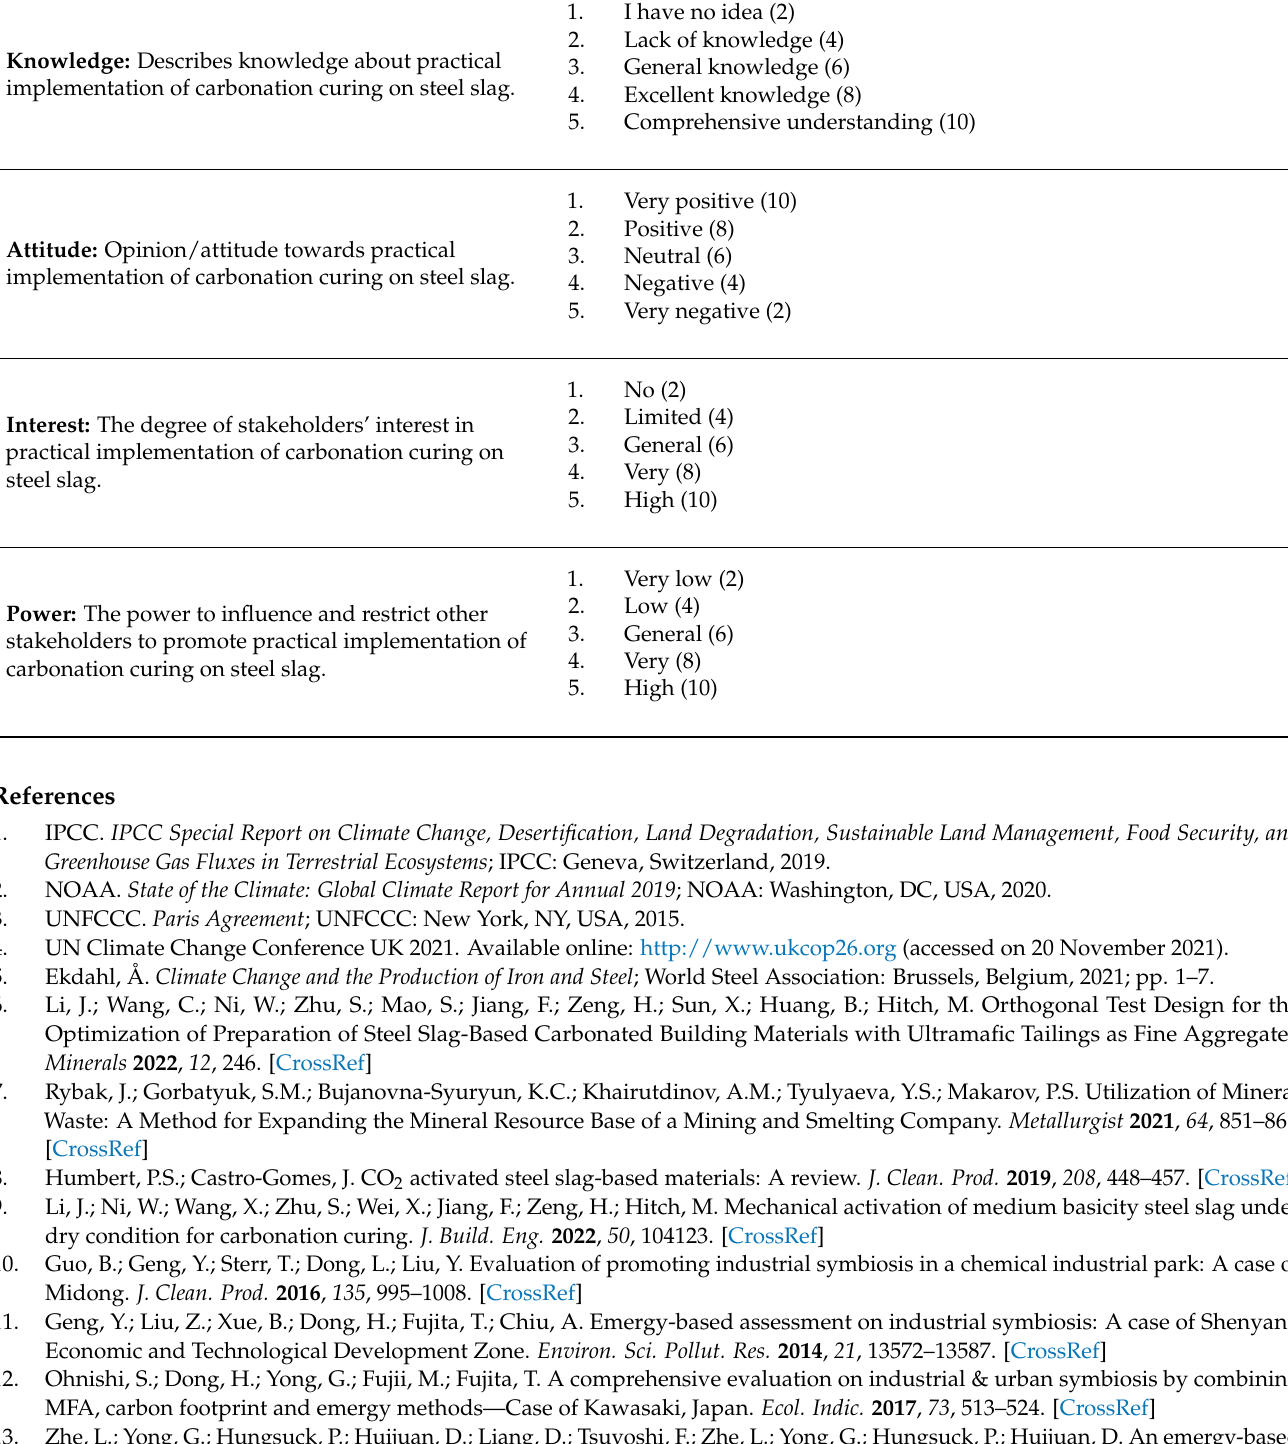
Table A1. Scoring of the questionnaire for the practical implementation of carbonation curing on steel slag. Topic Possible Scoring Your